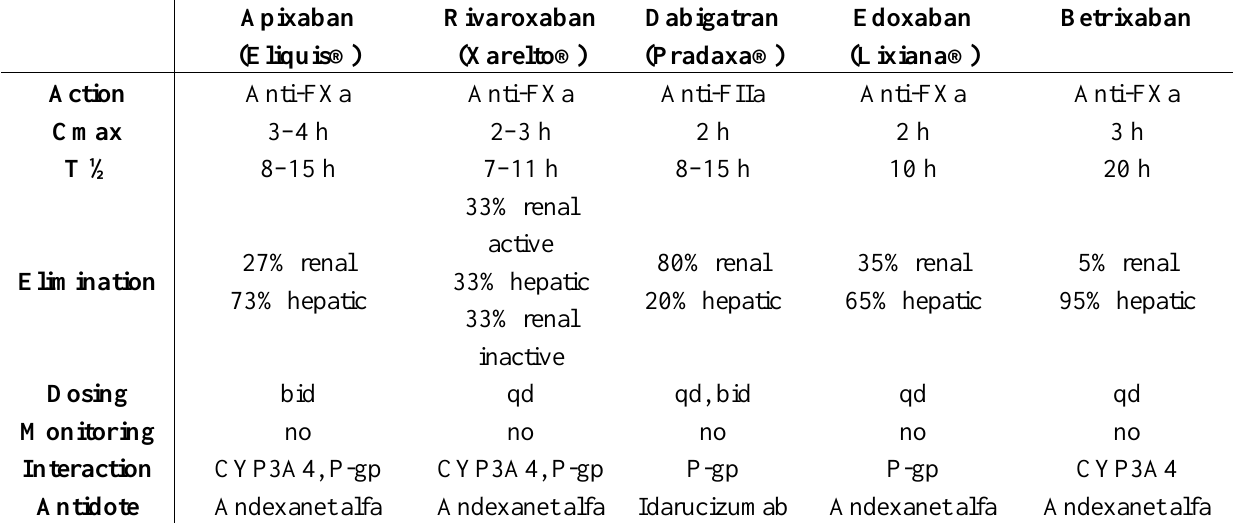
Table 1. The new direct oral anticoagulants (DOAC) and their mode of